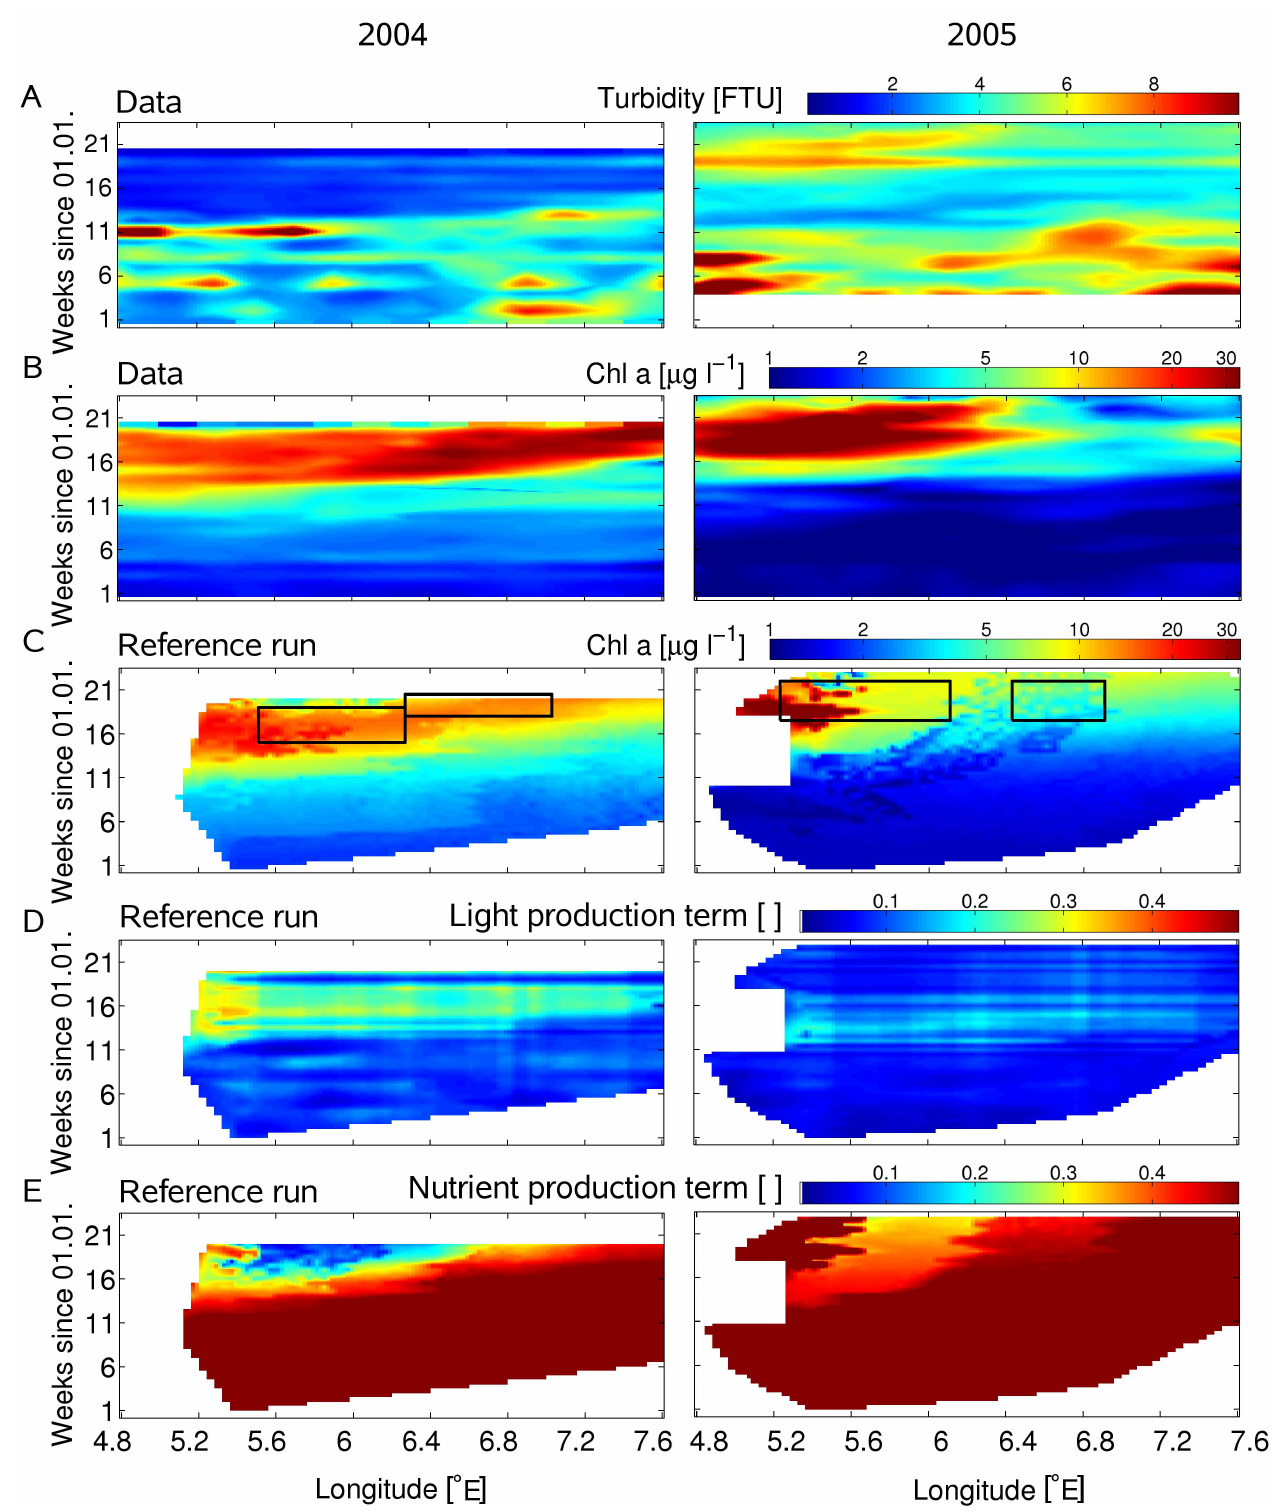
Fig. 5. (A) Turbidity measured by the FerryBox between Cuxhaven, Germany and Harwich, UK in 2004 and 2005 (Fig. 1); See Appendix for more details on the data treatment. (B) CHL- a measured by the FerryBox (cf. A). (C) Simulated CHL- a concentration; squares indicate areas that are used to calculate the CHL- a gradient for the sensitivity study (see Sect. 3 for more details); the data gap at the western edge in 2005 is due to missing particle coverage. (D) Simulated light production term (Eq. 1, A5). (E) Simulated nutrient production term (Eq. 1,